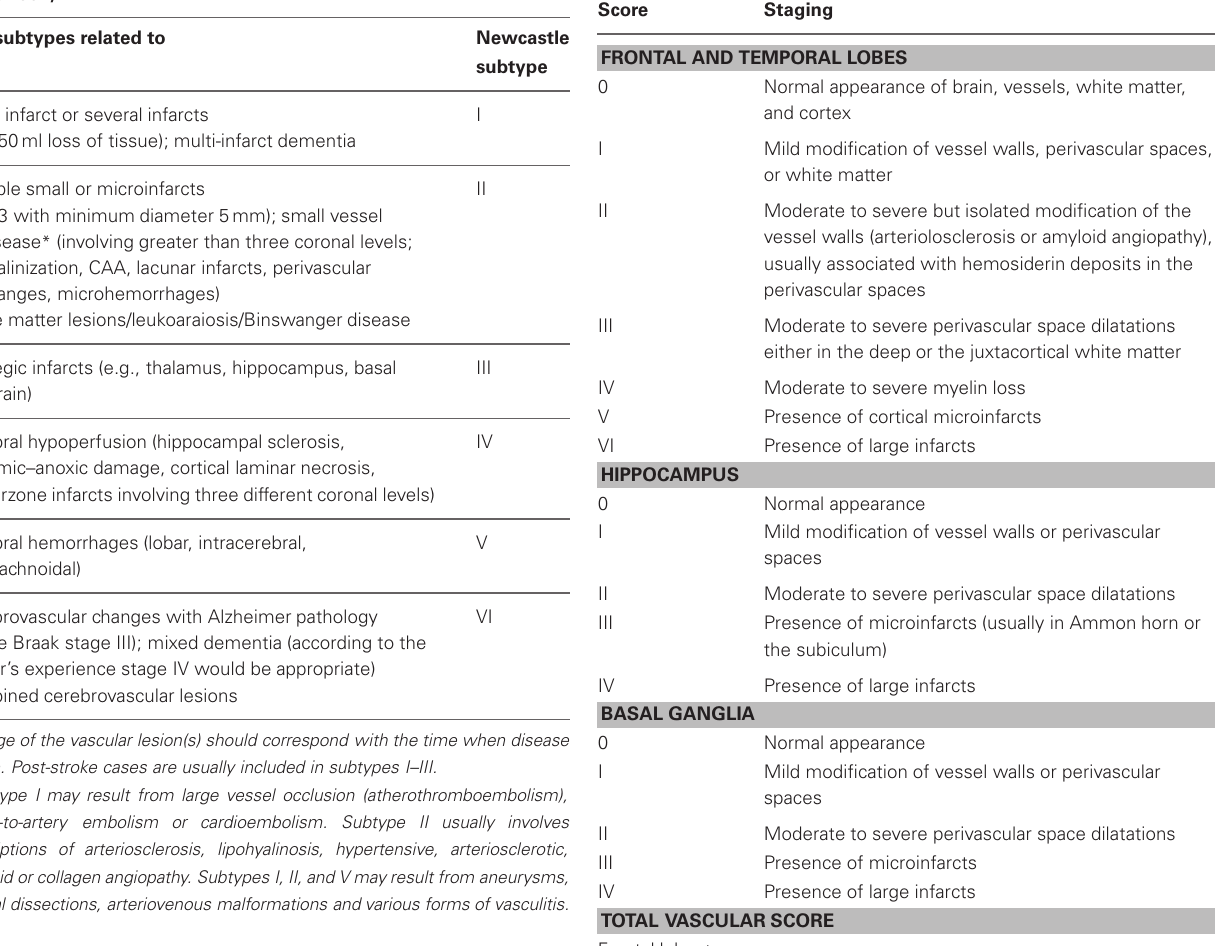
Table 11 | Newcastle categorization of the major cerebrovascular lesions associated with cognitive impairment (modified from Kalaria et al.,